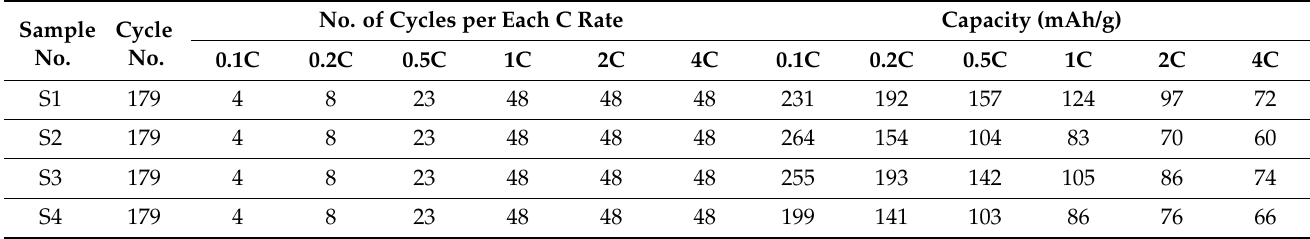
Table 2. Electrochemical performance of the produced